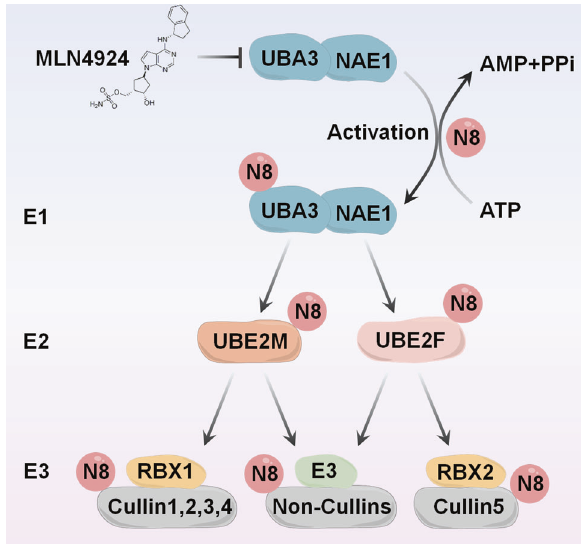
Fig. 1 The process of protein neddylation. Neddylation is a process that conjugates NEDD8 to cullins or non-cullin substrates via a three-step reaction, catalyzed by NEDD8-activating enzyme E1 (a heterodimer of NAE1 and UBA3), NEDD8-conjugating enzyme E2 (UBE2M or UBE2F) and substrate-speci fi c NEDD8-E3 ligases (e.g., RBX1 and RBX2). MLN4924: an inhibitor of UBA3; N8: neuronal precursor cell-expressed developmentally downregulated protein